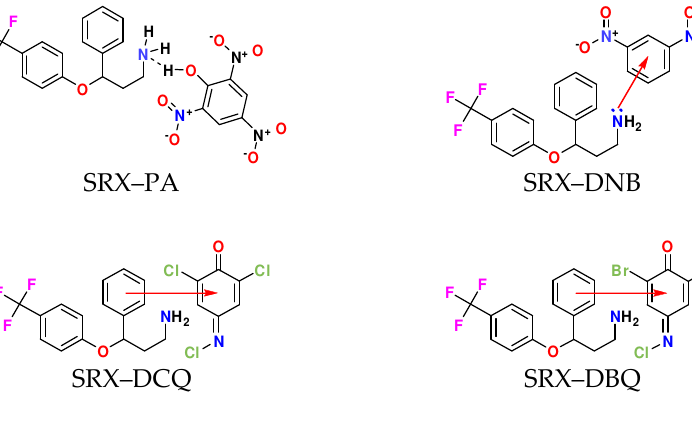
Figure 1. Speculated molecular structures of (1:1) charge-transfer complexes [(SRX)(π-acceptor)]. At room temperature, the mixtures were agitated for about an hour in each case. The precipitate was filtered and washed with the smallest amount of dichloromethane possible before being dried under vacuum over anhydrous CaCl 2